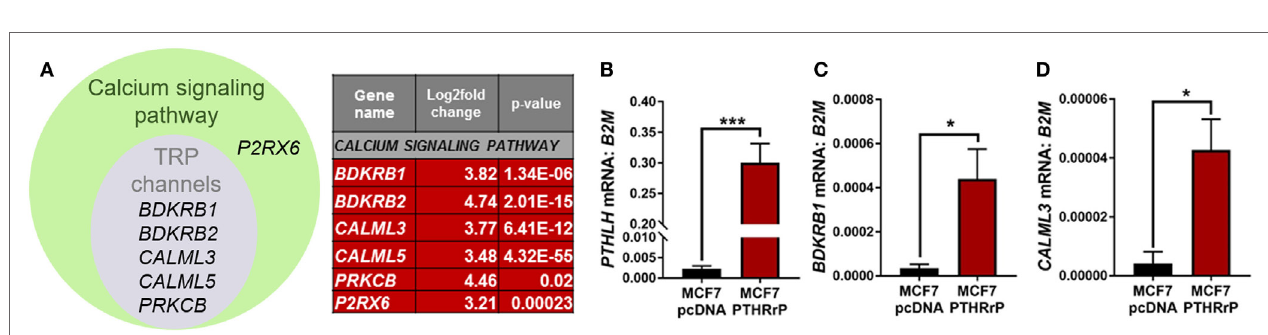
FigUre 4 | Multiple signaling pathways are upregulated in MCF7 parathyroid hormone-related protein-overexpressing cells. (a) STRING network analysis of the top 250 upregulated genes (with log 2 fold change > 1 and p < 0.05). Colors of each node correspond to the KEGG pathway indicated in (c) . (B) STRING network analysis of the top 250 downregulated genes (with log 2 fold change <− 1 and p < 0.05). (c) KEGG biological pathways significantly enriched for in the STRING analysis of the top 250 upregulated genes. There were no significantly enriched KEGG biological pathways for the top 250 downregulated genes. Colors correspond to the nodes in (a) .